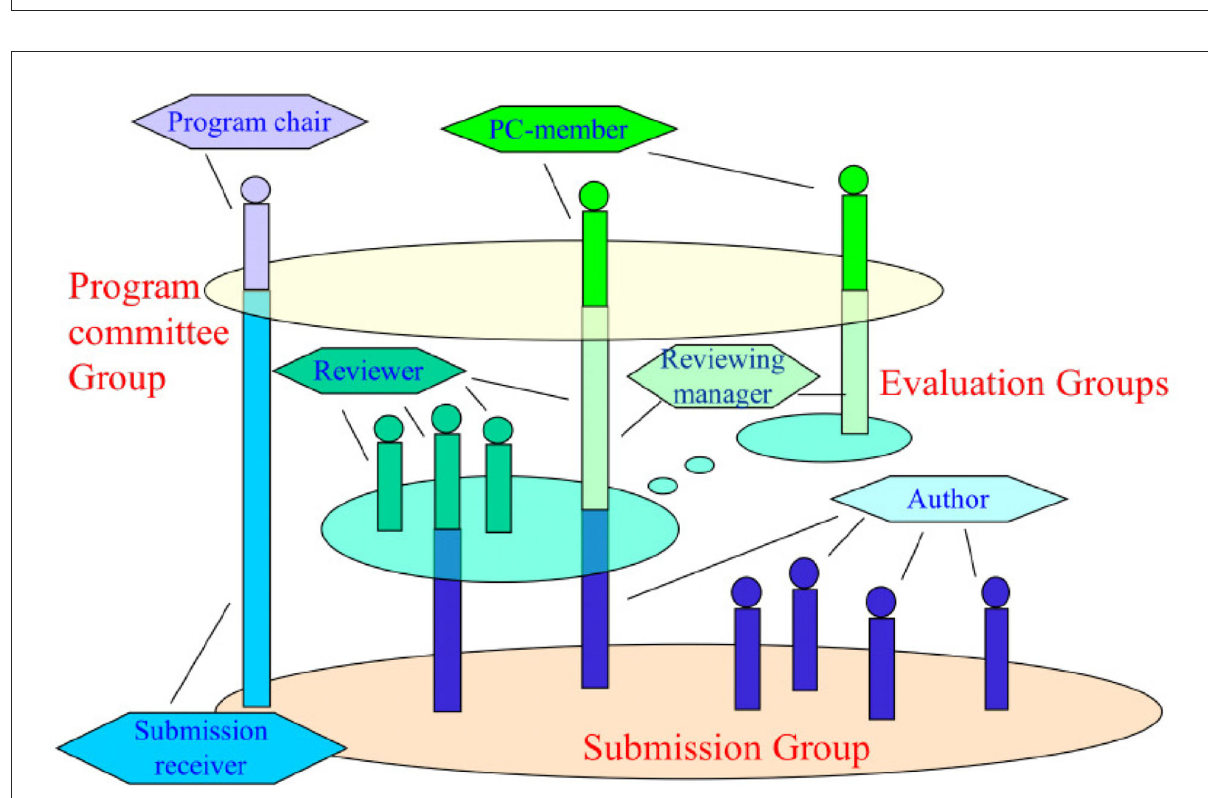
FIGURE9 The cheese-board diagram describing the EasyChair’s organizations in AGR